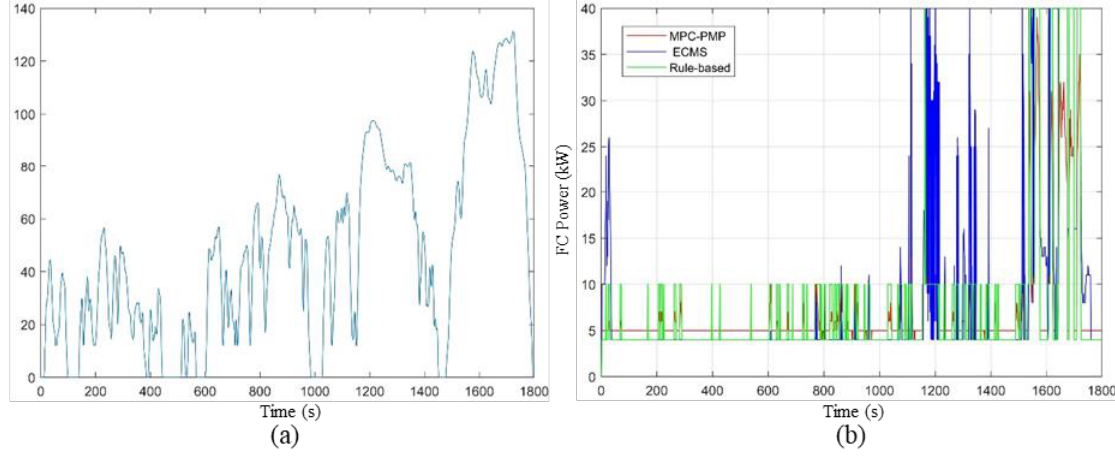
Figure 9. Optimized results under WLTC conditions: ( a ) WLTC test conditions; ( b ) optimized power waveform of three algorithms.